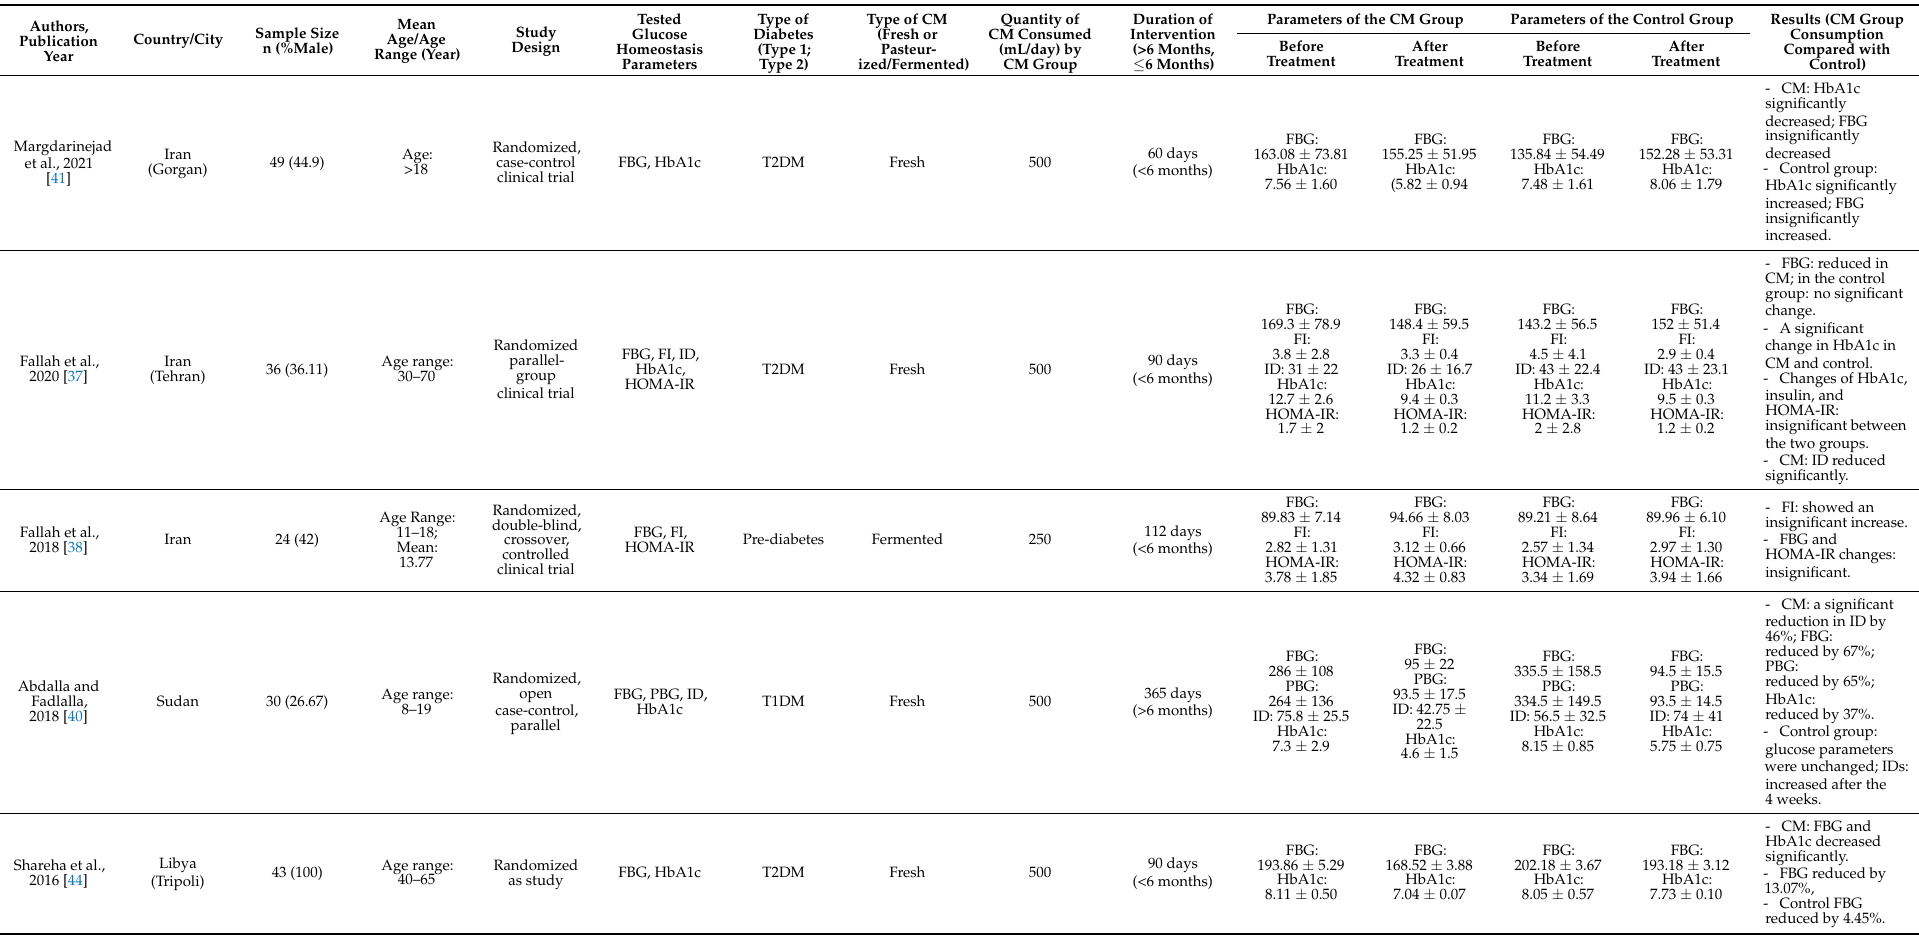
Table 2. Characteristics and major findings of the included studies on the effect of camel milk (CM) intake on glucose homeostasis parameters in patients with